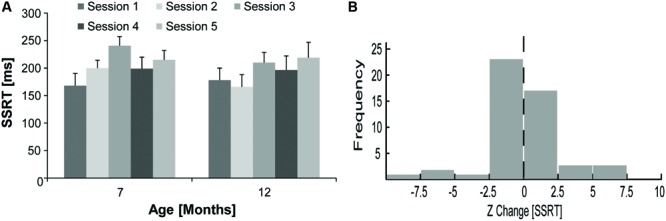
Stop signal response time for rats at 7 and 12 months of age. (A) Mean ± SEM SSRT in five individual countermanding task sessions (light–dark gray) for rats (N = 10) at 7 and 12 months of age. (B) Frequency distribution (n = 50) for the Z change in SSRT for rats (N = 10) comparing mean SSRT in five individual sessions at 12 months of age to their overall mean SSRT over five sessions at 7 months of age.